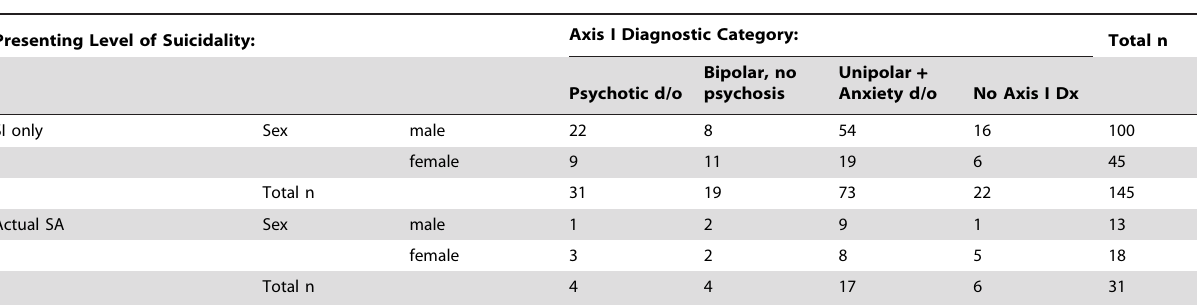
Table 3. Distribution of Suicide Attempt and Ideation by Sex and Diagnostic